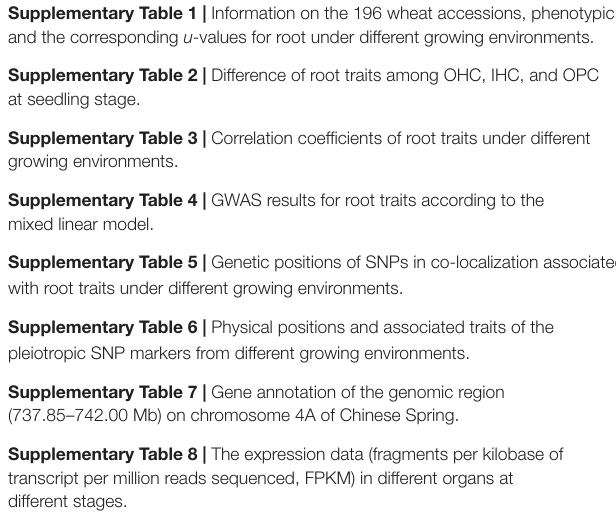
Supplementary Figure 4 | Manhattan and quantile-quantile (Q-Q) plots for root traits. Supplementary Figure 5 | Haploview plot for LD decay within the candidate region on chromosome 4A and TRL phenotypic effect of allele variation.